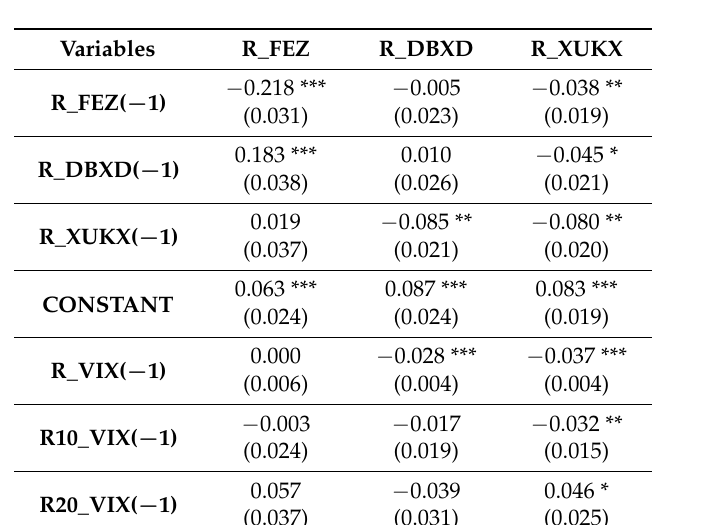
Table 8. Mean Equation for European Market ETF and VIX (whole period) (10 September 2007 to 30 March 2015).